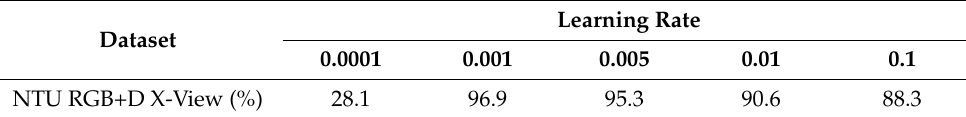
Table 5. Top 1 accuracy from various learning rates.